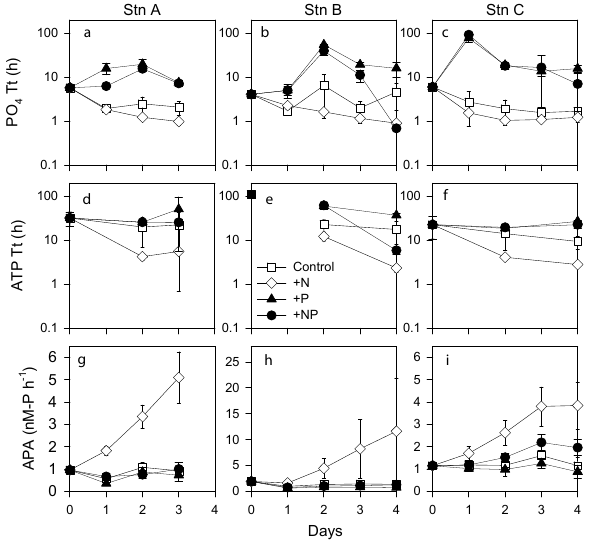
Fig. 2. Temporal changes in turnover time (h) of PO 4 ( a, b, c ) and ATP ( d, e, f ), and alkaline phosphatase activity (APA:nM-Ph − 1 ) ( g, h, i ) in different treatments (mean ± SD). Open square, open di- amond, closed triangle, and closed circle denote Control, +N, +P, and +NP, respectively. Closed square symbol denotes a datum ob- tained from the surface mixed water (5m) which was chronologi- cally closest to the start of the microcosm experiment.